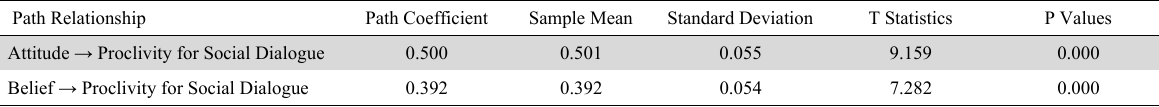
Fig. 4. Discriminant validity (HTMT) result Bootstrapping result of Smart PLS showing the direct path